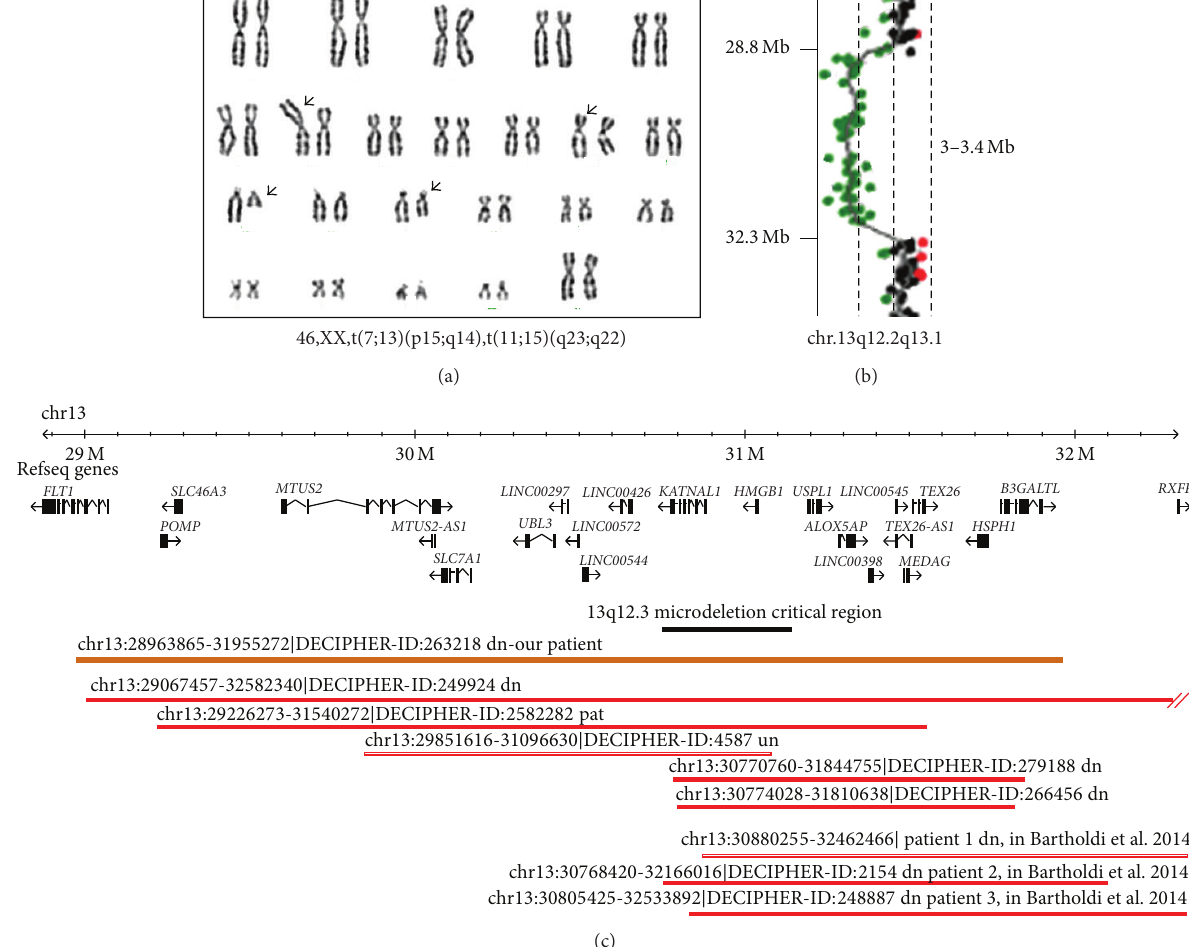
Figure 1: Karyotype, array-CGH analysis and schematic representation of the deleted region with reported DECIPHER cases. (a) The G- band karyotype of the patient. Black arrows indicate translocated chromosomes. (b) Chromosome 13 array-CGH results [arr 13q12.2q13.1 (28,875,081x2, 28,963,865-31,955,272x1, 32,313,799x2)dn]. (c) A scheme of the deleted region with distances in Mb and the Refseq genes are reported (GRCh37/hg19). The region deleted in our patient (code: 263218, orange bar) and the overlapping reported deletions (red bars) as shown by the Decipher database (http://decipher.sanger.ac.uk/, version 5.1) are reported. Above each bar the extension of the rearrangement and the mode of inheritance is reported (dn: de novo ; pat: paternal origin, and un: